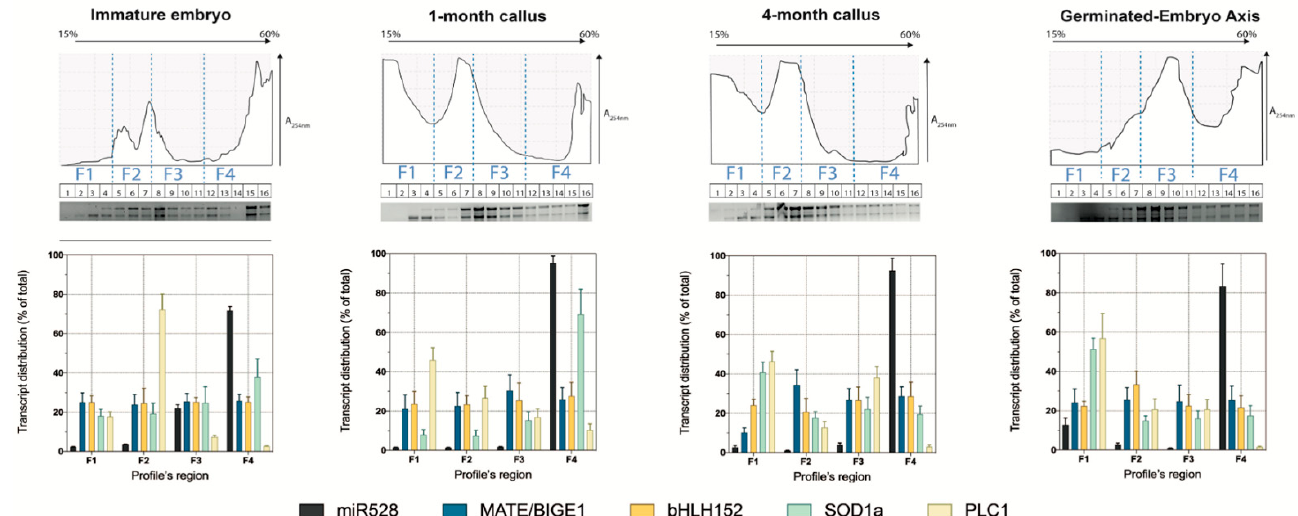
Figure 5. Distribution of zma-miR528 and targets in polysomal fractions. Upper panels show profiles for the immature embryo, one-month callus, four-month callus, and germinated embryo axis. Each profile is composed of 16 minor fractions further pooled into broader fractions according to the absorbance profile and rRNA observation on depicted agarose gels: F1 (free RNA and ribonucleoproteins complexes), F2 (monosomes), F3 (light polysomes), and F4 (heavy polysomes). Lower panels display the distribution of miR528 and some targets in each fraction. The percentage level was calculated for each transcript using the lower Ct value as a normalizer. Error bars indicate ± SD of two biological replicates with three technical replicates for each one ( n = 6). A254 nm: absorbance value at 254 nm wavelength.